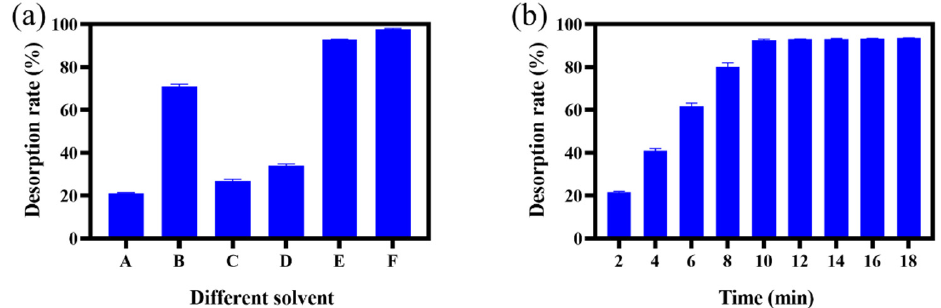
Figure 12. ( a ) The reusability of PILs and ( b ) the recycle time of PILs. 2.7. SEM Characterization As shown in Figure 13, after incubation with TPs, the surface of PILs got rough, which indicated that the active sites were occupied. After desorption, the surface structure of PILs was recovered, implying that PILs possess multi-usage propositions. SEM charac- terization showed the effects of adsorbed compounds on the PILs surface, which was con- sistent with the results of the single-molecule adsorption obtained by adsorption thermo- dynamics research.